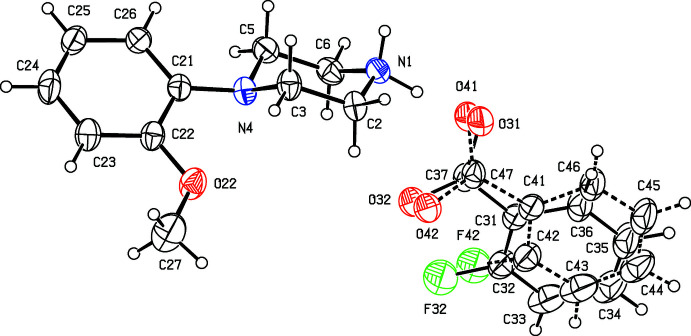
The independent components of compound (IV) showing the atom-labelling scheme and the disorder in the anion; the major disorder component is drawn using full lines and the minor disorder component is drawn using broken lines. Displacement ellipsoids are drawn at the 30% probability level.